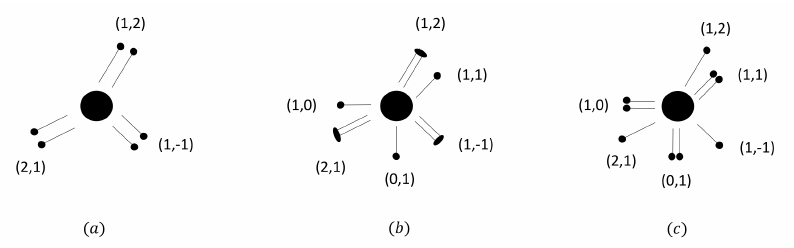
Figure 3 . The brane web representations for some of the Z 3 symmetric 5 d SCFTs. (a) shows the case of the 5 d SCFT whose compactifications gives theory 60, that is the N = 4 SU(3) theory. (b) shows the case of the 5 d SCFT whose compactifications gives theory 63, which is one of the N = 3 theories. (c) shows the case of the 5 d SCFT whose compactifications gives theory 46. In all cases we are only interested in the external legs and not in how these are connected to one another, which is instead represented by a black blob. The parenthesis gives the 7 -brane charges of the corresponding 7 -branes, or alternatively, the 5 -brane charges of the 5 -branes ending on